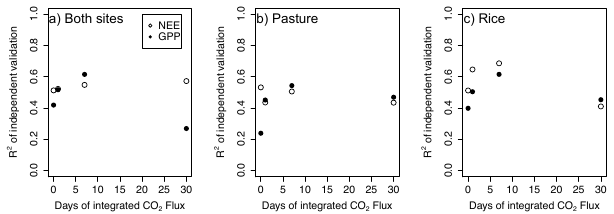
Figure 7. Predictive power of measured hyperspectral reflectance at